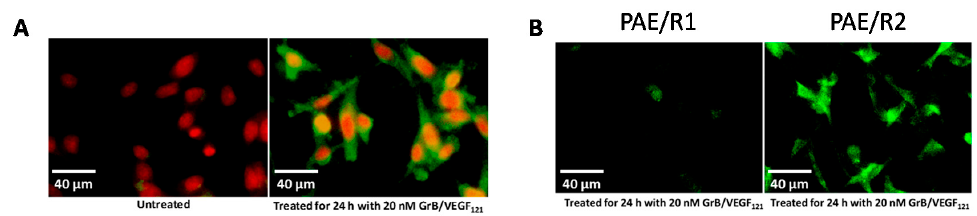
Figure 3. In vitro internalization of GrB/VEGF 121 into target cells. ( A ) GrB/VEGF 121 efficiently internalized into VEGFR-2-overexpressing endothelial cells within 24 h. ( B ) The efficiency by which GrB/VEGF 121 internalizes into VEGFR-2-overexpressing endothelial cells over VEGFR-1- overexpressing cells.